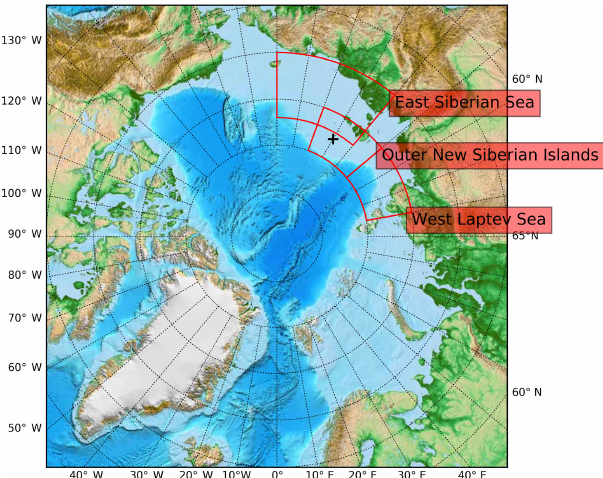
Figure 3. Target regions along the NSR. Black cross indicates a location for further use in Fig. 14.